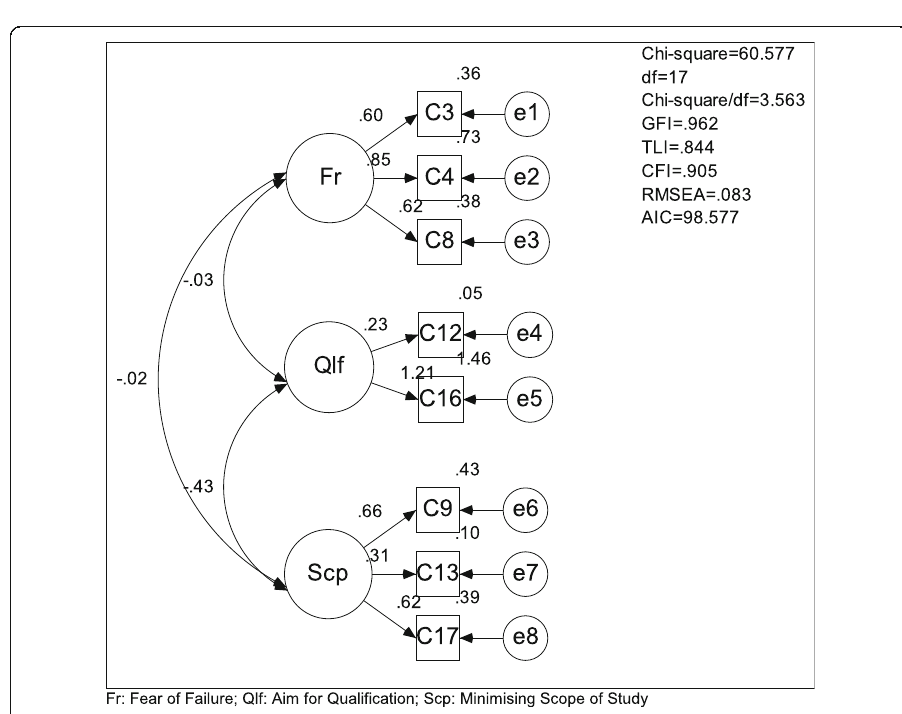
Fig. 4 The initial measurement model of surface approach after removing the scales of